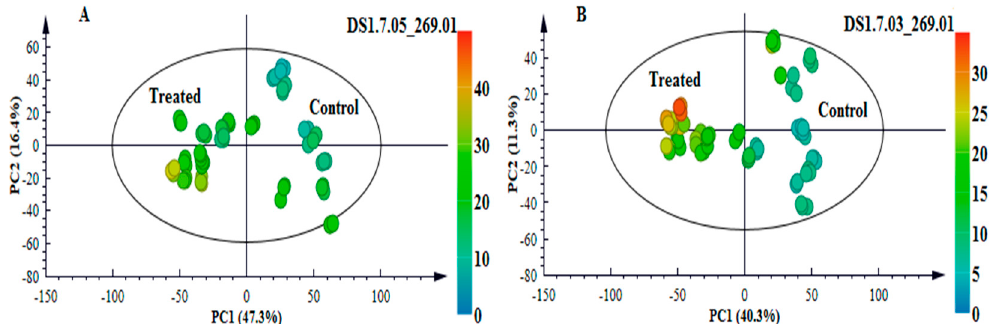
Figure 7. An unsupervised colour-coded PCA score plot displaying the presence/absence and intensity of the phytoalexin apigenin across the samples. ( A ): NS 5511 (BT) and ( B ): NS 5655 (ST). The absence of the metabolite in control samples and presence in samples from infected plants indicates that the metabolite was pathogen-induced.